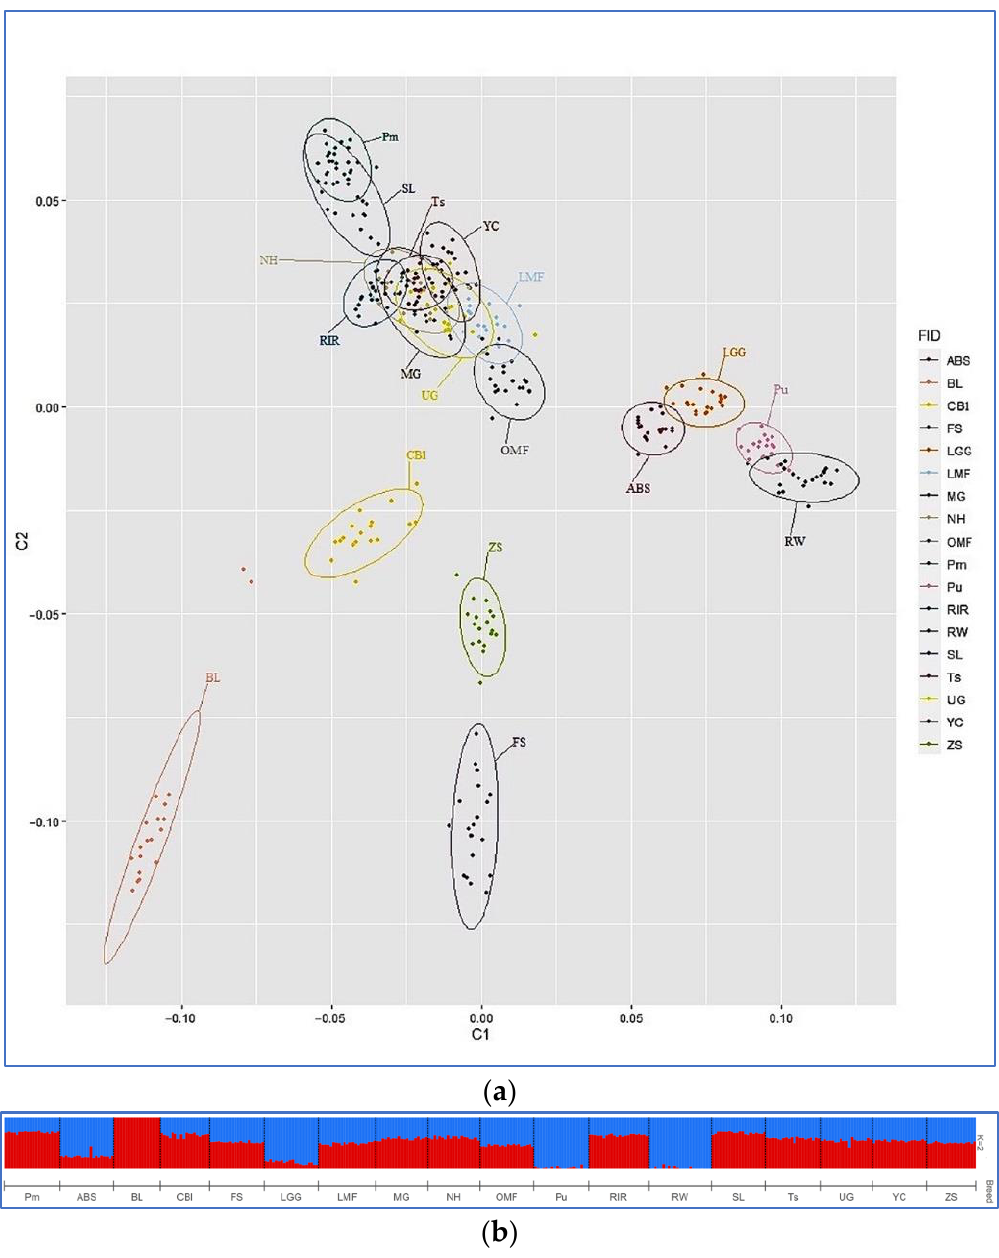
Figure 4. Visualization of the MDS and ADMIXTURE hierarchical clustering based on genotyping information (356 individuals from 18 breeds genotyped for 38,711 SNPs). ( a ) Results of the MDS analysis. Individuals are plotted on the two coordinate axes, C1 and C2, according to their coordinates. Ellipses describe how each breed is dispersed around its center of gravity. ( b ) ADMIXTURE hierarchical clustering analysis for K = 2 predefined clusters (ancestral populations). The proportions of each cluster ( y -axis) that were defined to be indicative of European (egg-type) and Asiatic (meat-type) ancestries (according to [62]) are plotted in blue and red, respectively, for each individual. Breeds: Pervomai (Pm), Australorp Black Speckled (ABS), Brahma Light (BL), Cochin Blue (CBl), Faverolles Salmon (FS), Leningrad Golden-and-gray (LGG), Leningrad Mille Fleur (LMF), Moscow Game (MG), New Hampshire (NH), Orloff Mille Fleur (OMF), Pushkin (Pu), Rhode Island Red (RIR), Russian White (RW), Sussex Light (SL), Tsarskoye Selo (Ts), Uzbek Game (UG), Yurlov Crower (YC), and Zagorsk Salmon (ZS).